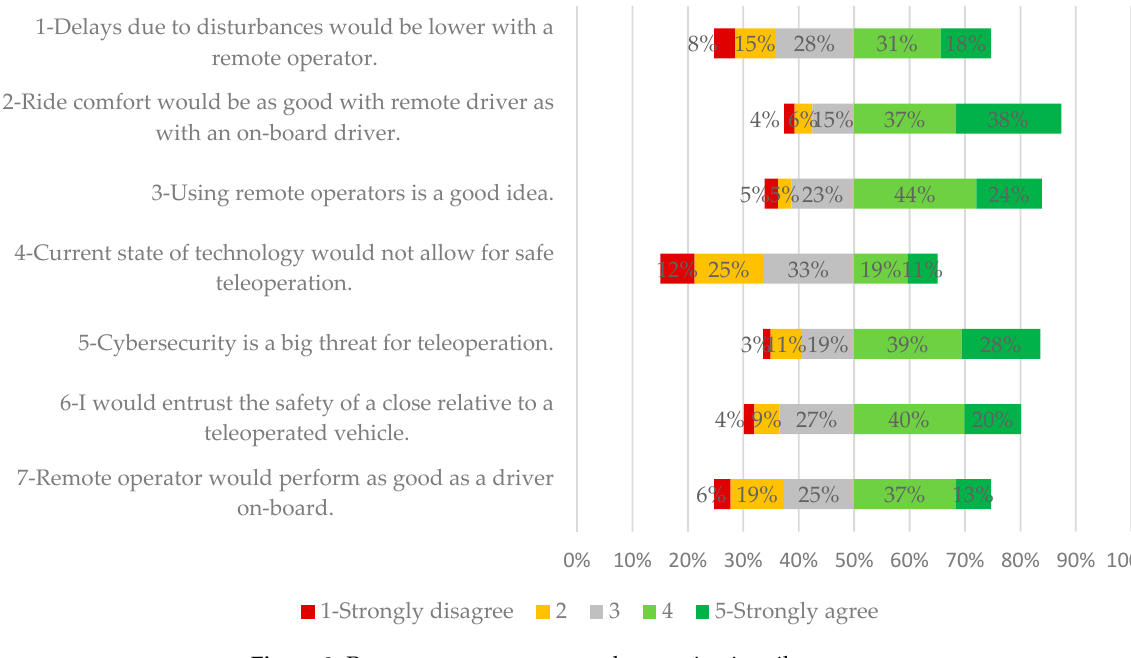
Figure 8. Passenger statements on teleoperation in railways.